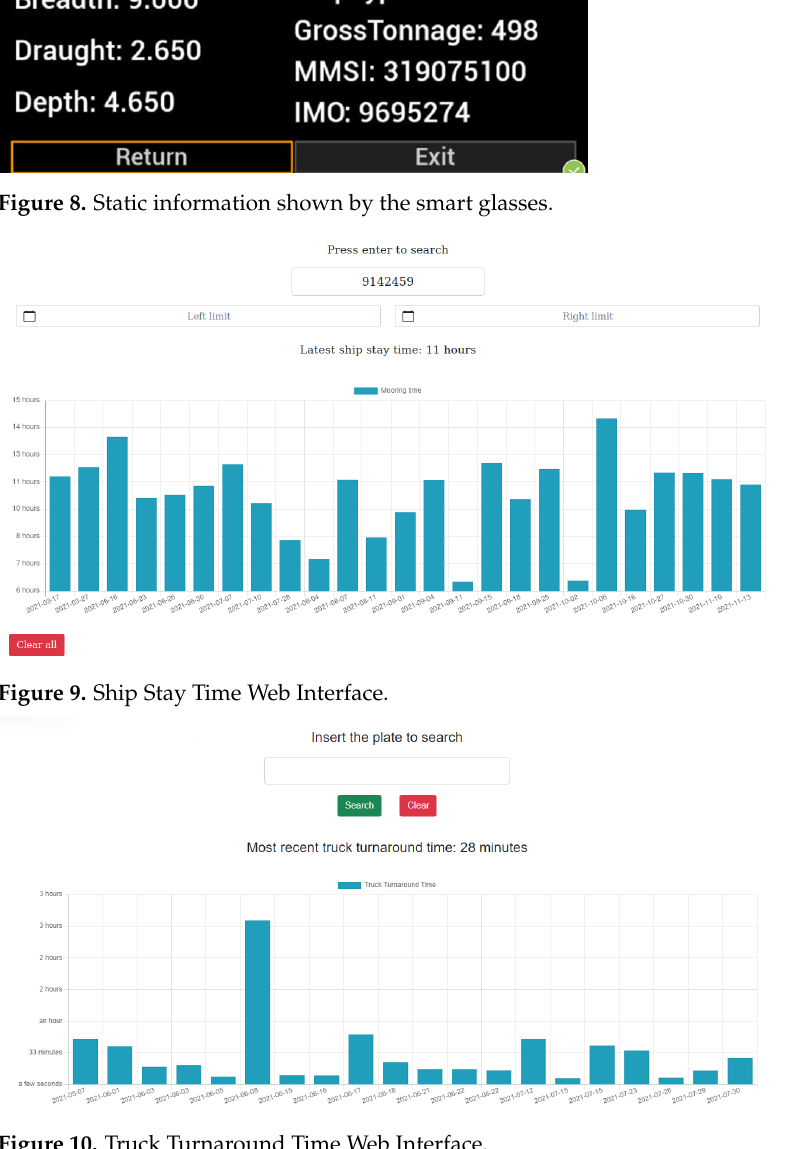
Figure 10. Truck Turnaround Time Web